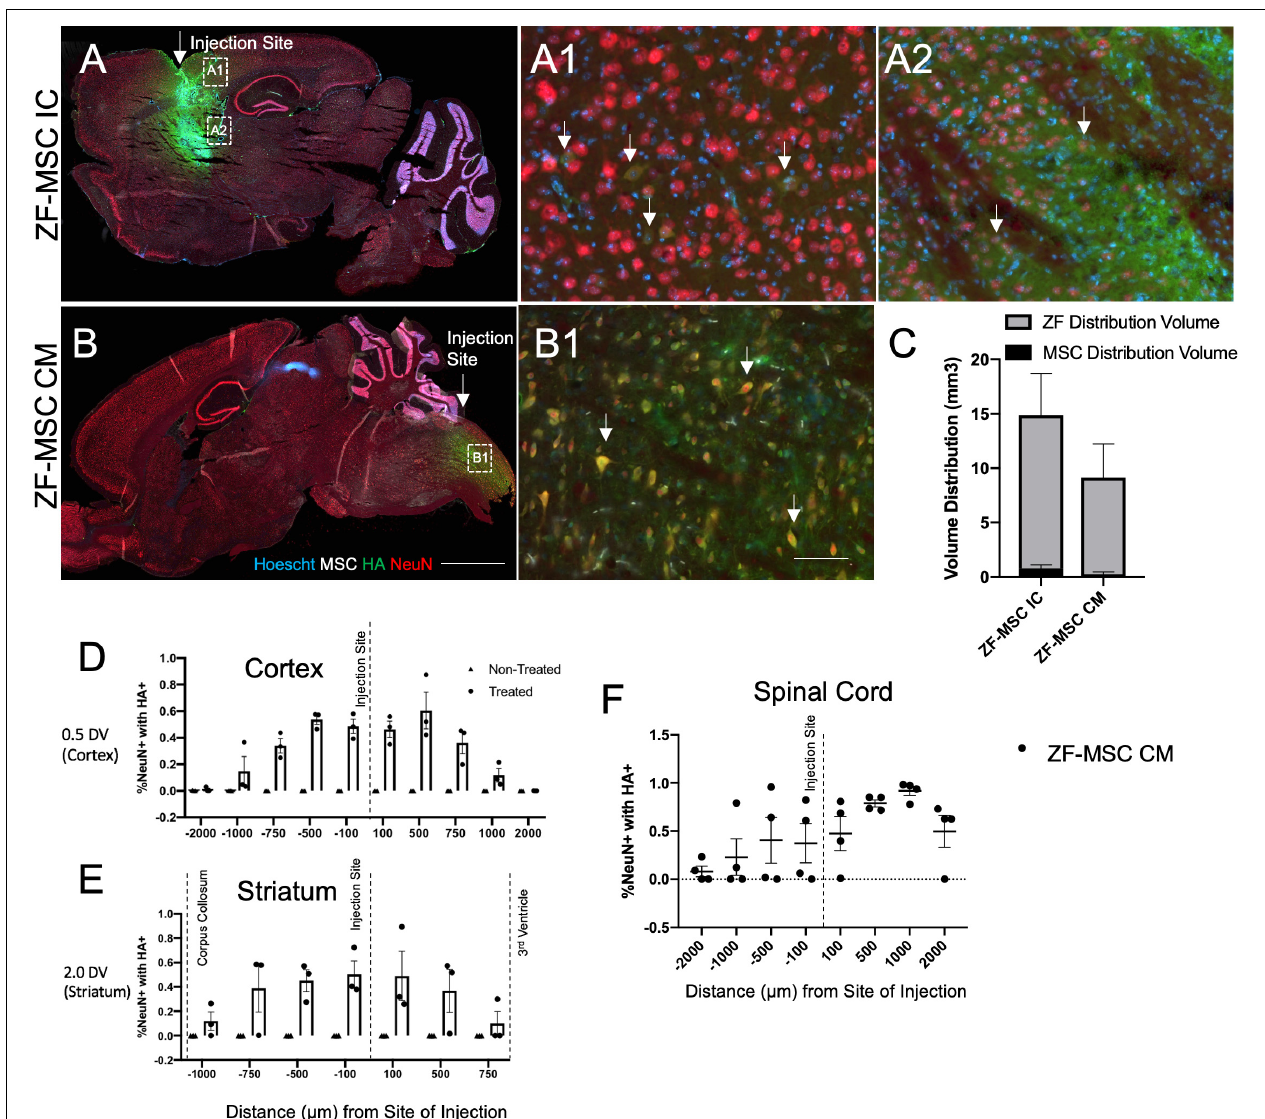
FIGURE 3 | Secreted zinc finger (ZF) diffuse in a gradient fashion from site of injection. (A) Intracranial injection of ZF-MSC into the striatum resulted in an observable ZF (red) distribution. Uptake of ZF is observable in mature NeuN+ (red) neurons in the cortex (A1) and the striatum (A2) . White arrows indicate ZF+/NeuN+ cells. (B) CM injection of ZF-MSC demonstrated observable ZF distribution and uptake of protein NeuN+ neurons in the spinal cord (B1) . White arrows indicate ZF+/NeuN+ cells. (C) Quantitation of volume distribution of ZF+ protein in the brain from injected cells from panels (A,B) . The gray bar indicates ZF distribution. The black bar indicates the volume of ZF-MSC bolus injection. (D) Quantitation of co-localization of ZF protein with NeuN+ cells. ZF/NeuN co-localization decreased from the site of injection in the cortex. (E) Quantitation of co-localization of ZF protein with NeuN+ cells. ZF/NeuN co-localization decreased from the site of injection in the striatum. Dashed lines indicate appearance of morphologically distinct neuronal landmarks. Error bars indicate ± standard error of the mean. (F) Quantitation of co-localization of ZF protein with NeuN+ cells. ZF/NeuN co-localization decreased in the spinal cord adjacent to the location of the CM administration. DV, dorsal ventral; NeuN+, neuronal nuclei; HA, hemagglutinin. Scale bar = 1,000 µ m (A,B) , 100 µ m (A1,A2,B1)